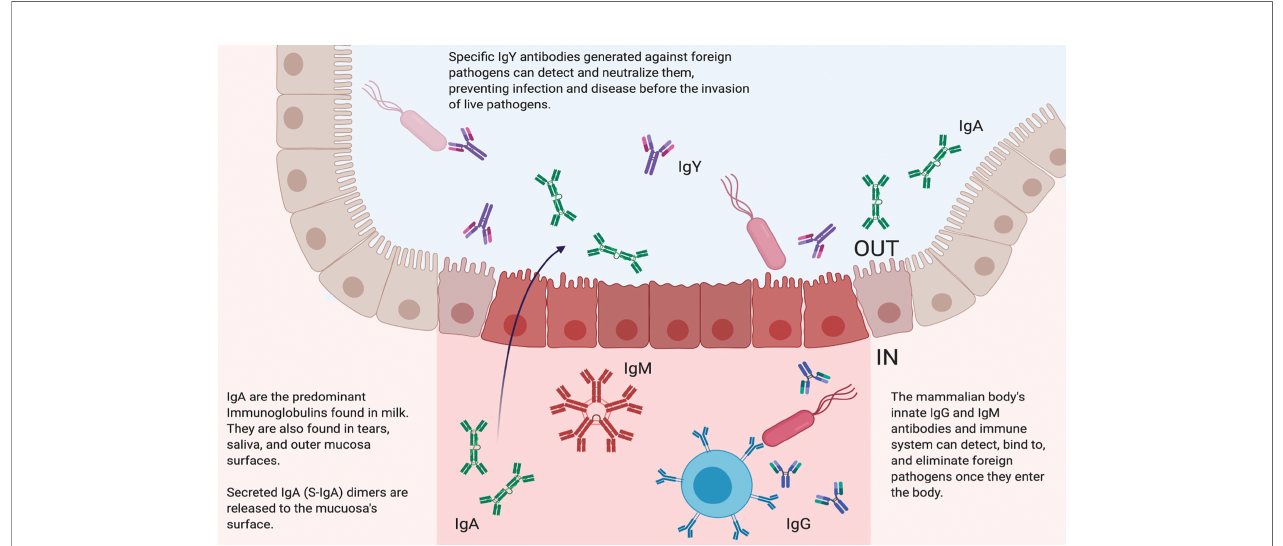
FIGURE 1 | Biological Function of Different Immunoglobulins. In mammals, immunoglobulin G (IgG) is the main antibody in the circulating bloodstream. IgG antibodies are characterized by two antigen recognition sites that act as crucial components of the immune system. These sites are involved in the detection and subsequent elimination of foreign invaders that may also be circulating in the bloodstream. Mammalians also produce immunoglobulin M (IgM) antibodies, which are found in blood and lymph fl uid and the fi rst antibodies to appear in response to antigen exposure. Immunoglobulin A (IgA) antibodies are the main immunoglobulins found in milk, tears, saliva, and mucosa. IgA is characterized by a unique dimer structure and released to the outer mucosa surface. Immunoglobulin Y (IgY) is the main antibody found in birds, reptiles, and amphibians. Because of their unique structures, IgY antibodies are particularly resistant to low pH, high temperatures, and proteolysis. IgY can be effectively administered prophylactically and therapeutically to detect and neutralize pathogens without activating the host ’ s native immune